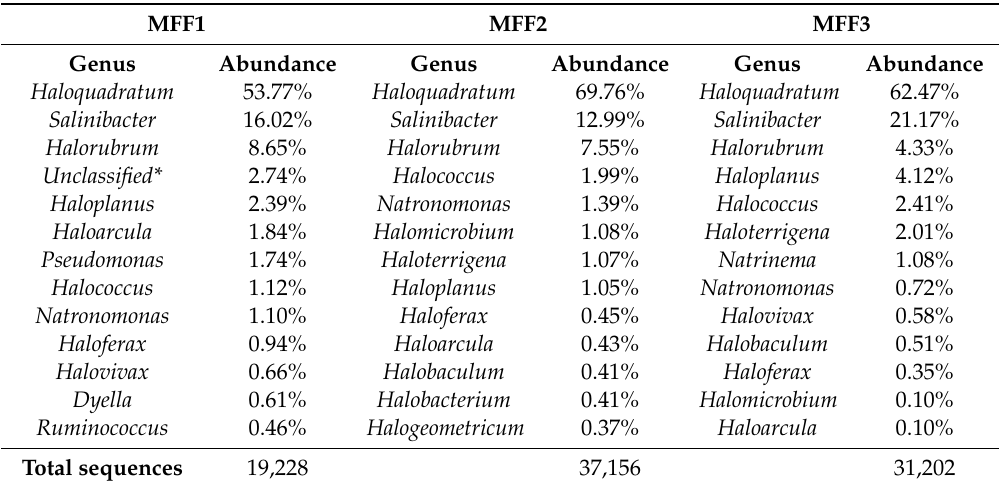
Table 2. Taxonomic composition at genus level for each metagenome, using 16SrRNA gene sequences. The percentage of reads aligning with a minimum length of 100 bp and 97% identity at genus level are shown. *Unclassified sequences belong to phylum Euryarchaeota. MFF1